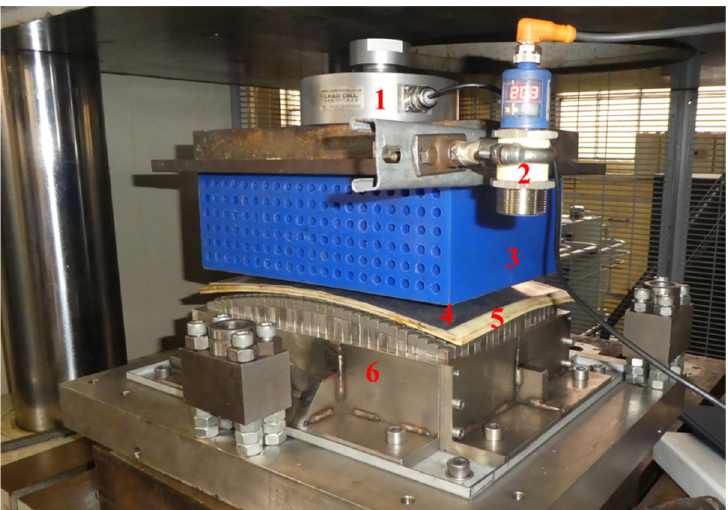
Figure 1. The experimental setup of the hole-type rubber multipoint forming. 1—Force Cell; 2—Displacement sensor; 3—Hole-type rubber punch; 4—Sheet blank; 5—Rubber cushion; 6—Lower pin